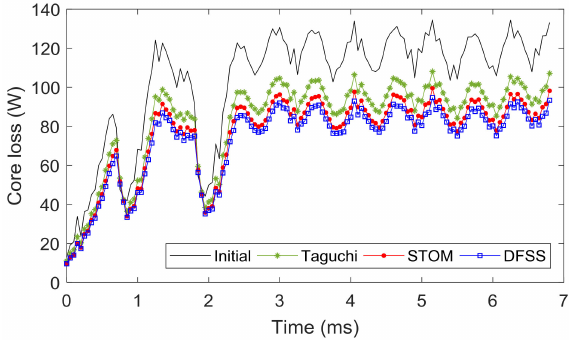
Figure 13. Core losses for the FSPMM with four